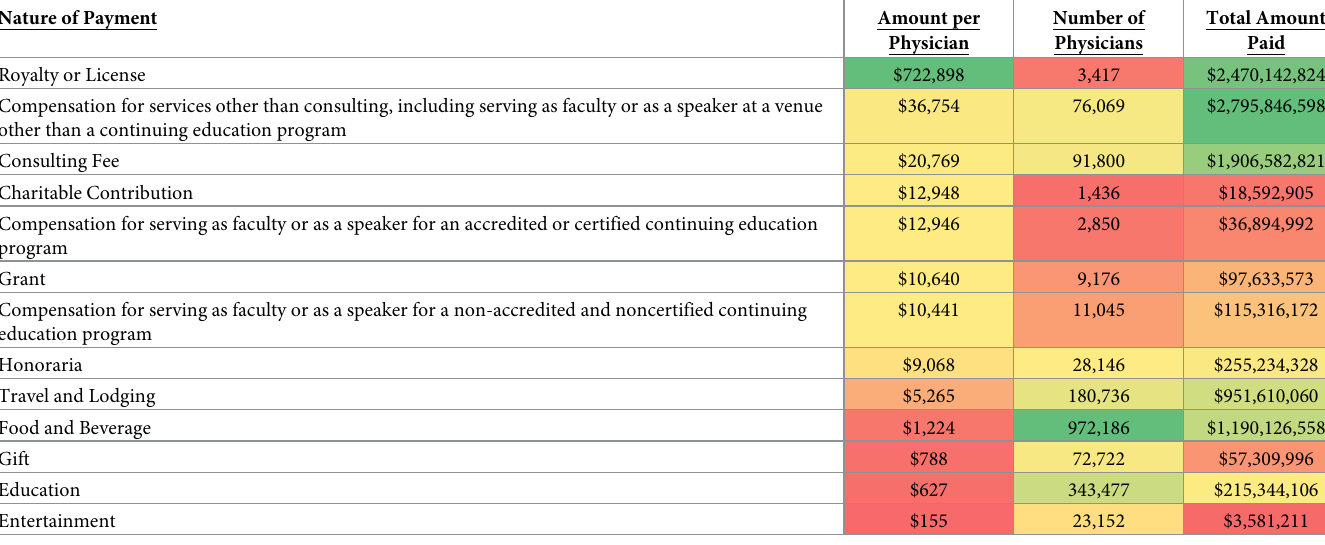
Table 2. For each type of payment category among general payments in the Open Payments database, 2013–2018, the mean payment per physician, the number of physicians receiving payments, and the total amount of money